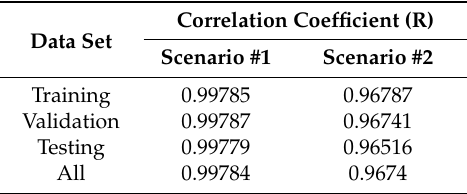
Table 3. The performance of ANNs model for the management Scenarios #1 and